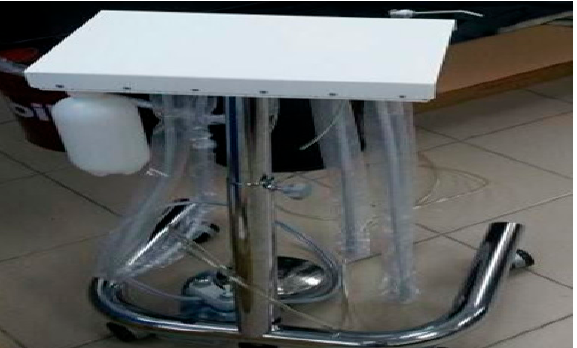
Figure 5. Schematic illustration and picture of in-house ATDH measurement platform.